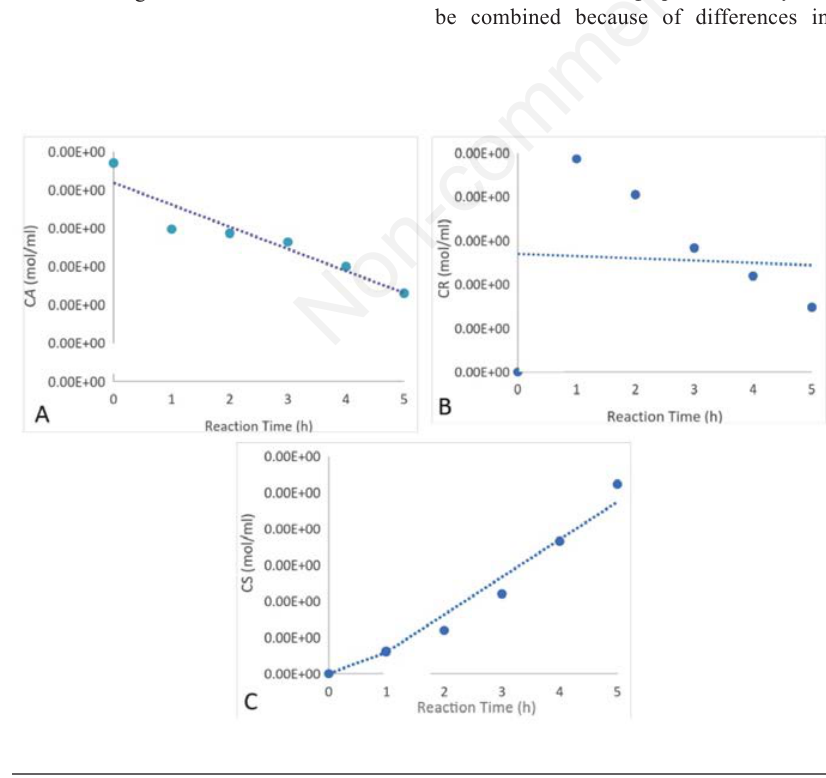
Figure 3. Relationship between (A) the concentration of residual cellulose (CA) vs time, (B) the concentration of CNCs (CR) vs time and (c) the concentration of glucose (CS) vs time.